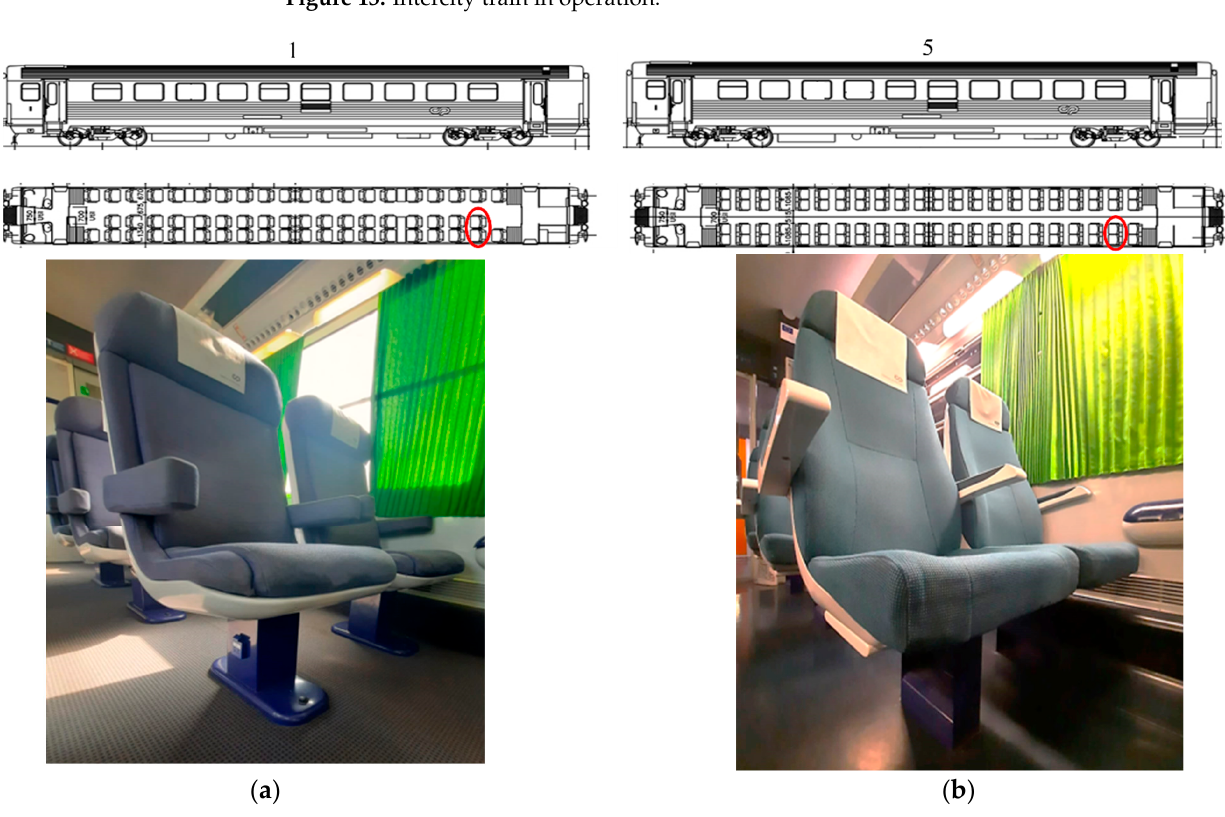
Figure 14. Intercity train seats: ( a ) comfort class; ( b ) standard class.